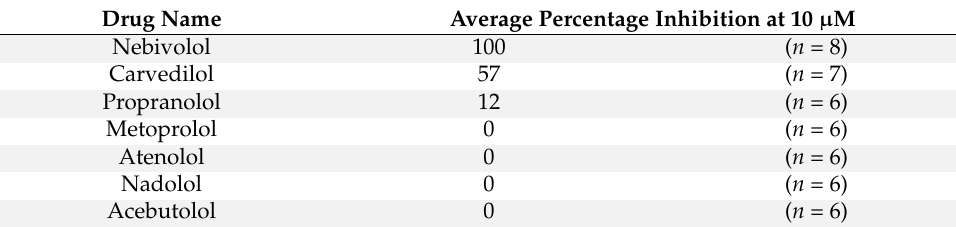
Table 2. TRPM8 percent inhibition